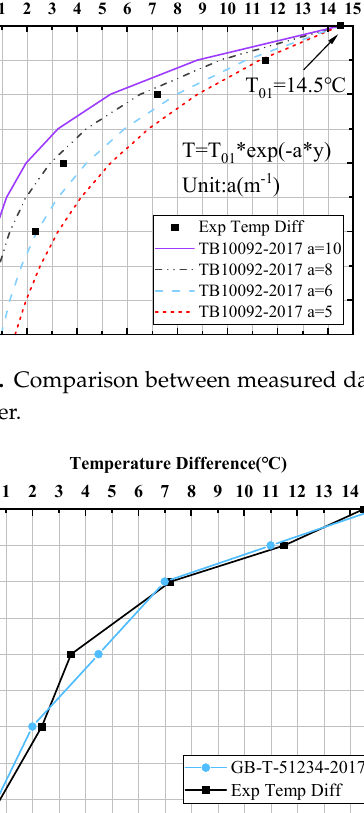
Figure 10. Comparison between measured data and multi-broken line curve fitting of the steel box girder.